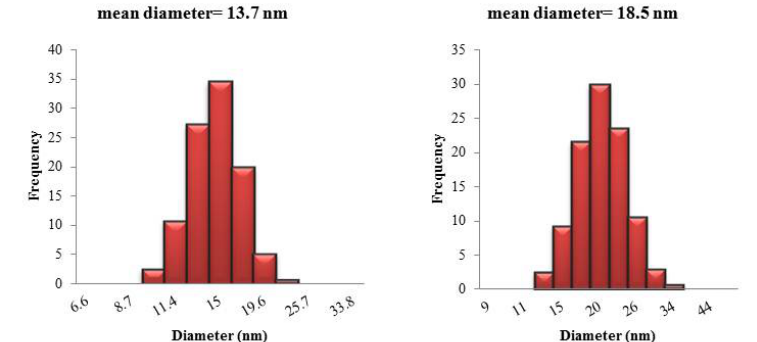
Fig. 1. TEM images of the (a) naked and (b) CM-βCD modified Fe Fig.1 TEM images of the (a) naked and (b) CM- β CD modified Fe 3 O 4